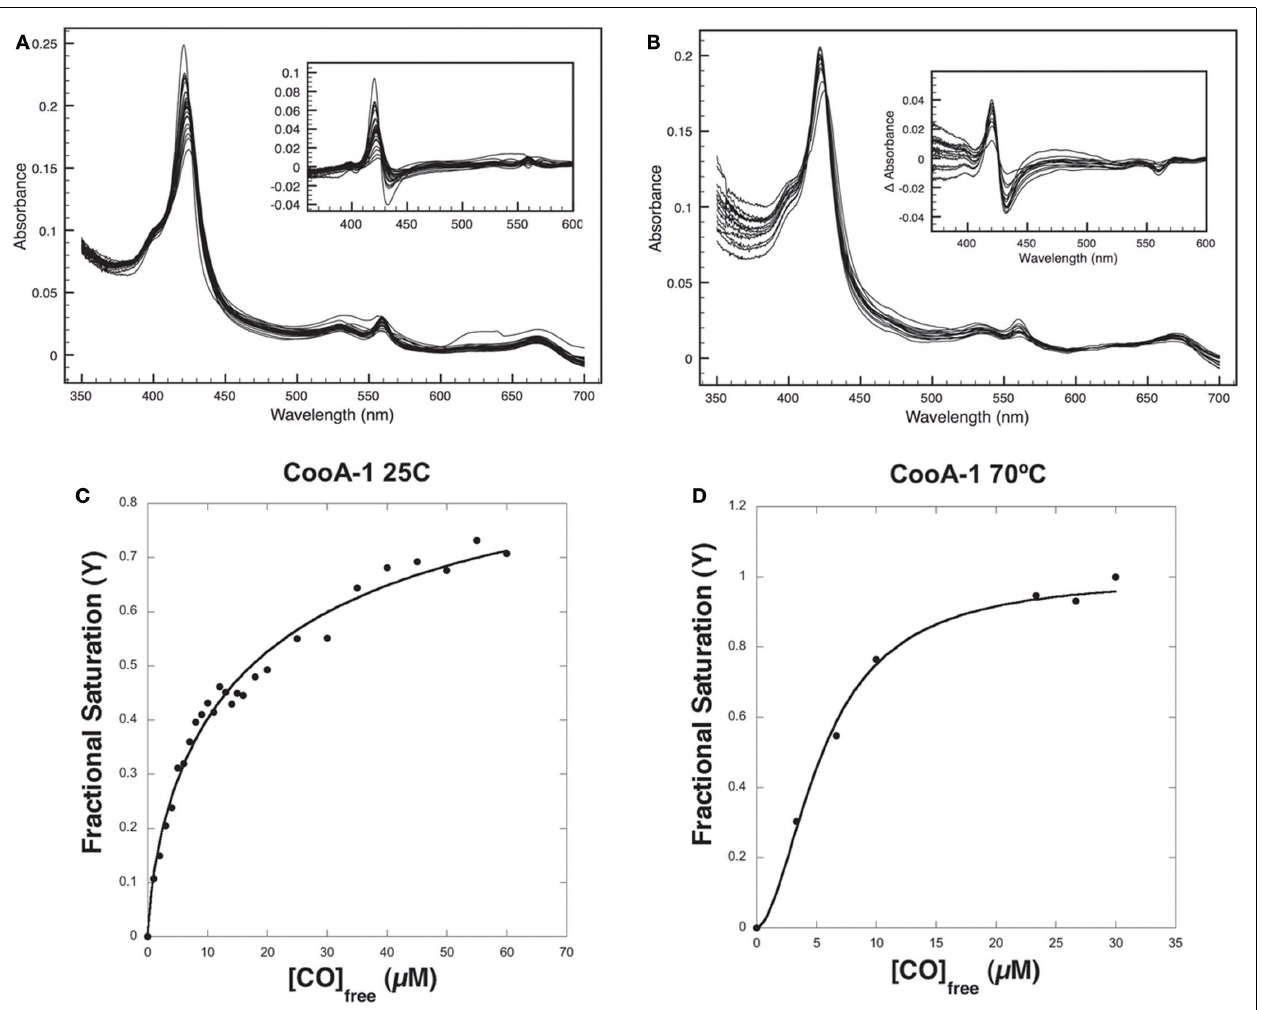
difference between each CO-bound curve and the No-CO curve. Fractional Saturation was plotted against [CO] and fit to the Hill equation for (C) CooA-1 at 25˚C and (D) CooA-1 at